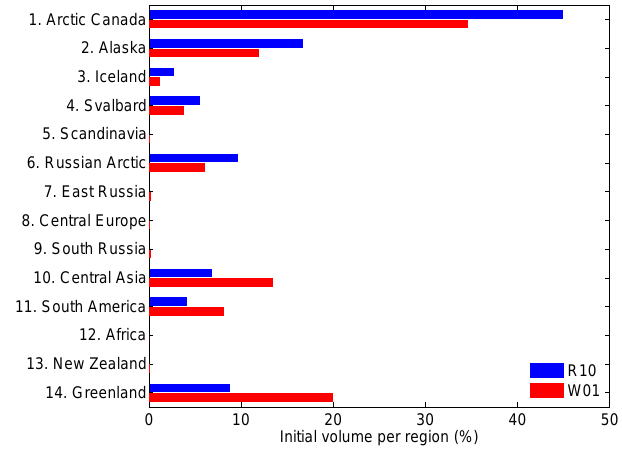
Fig. 6. Initial GIC volume per region relative to V i for the two inventories ( V i , R10 = V i , W01